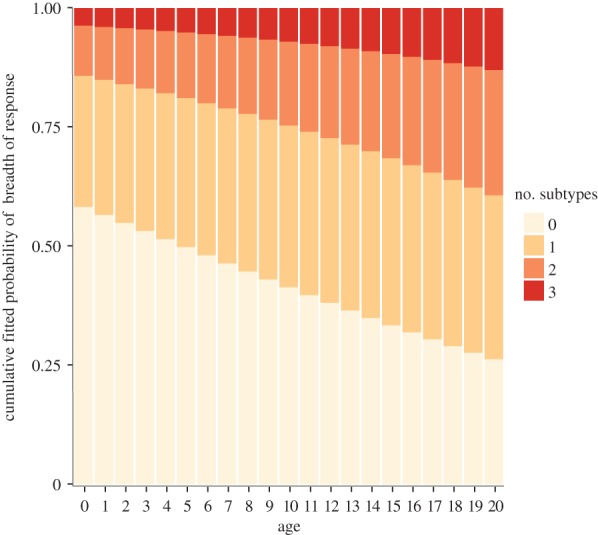
Cumulative fitted probabilities of effect of age on number of strains to which a swan exhibits a response (breadth of response) as determined by cumulative link models. Sex and sample year were included in the model, but do not significantly affect the probability of having a response, so for simplicity, data are shown for female birds in 2007. Breadth of response details the number of subtypes birds respond to (dataset A, including H9N2, H5N2 and H6N8). (Online version in colour.)